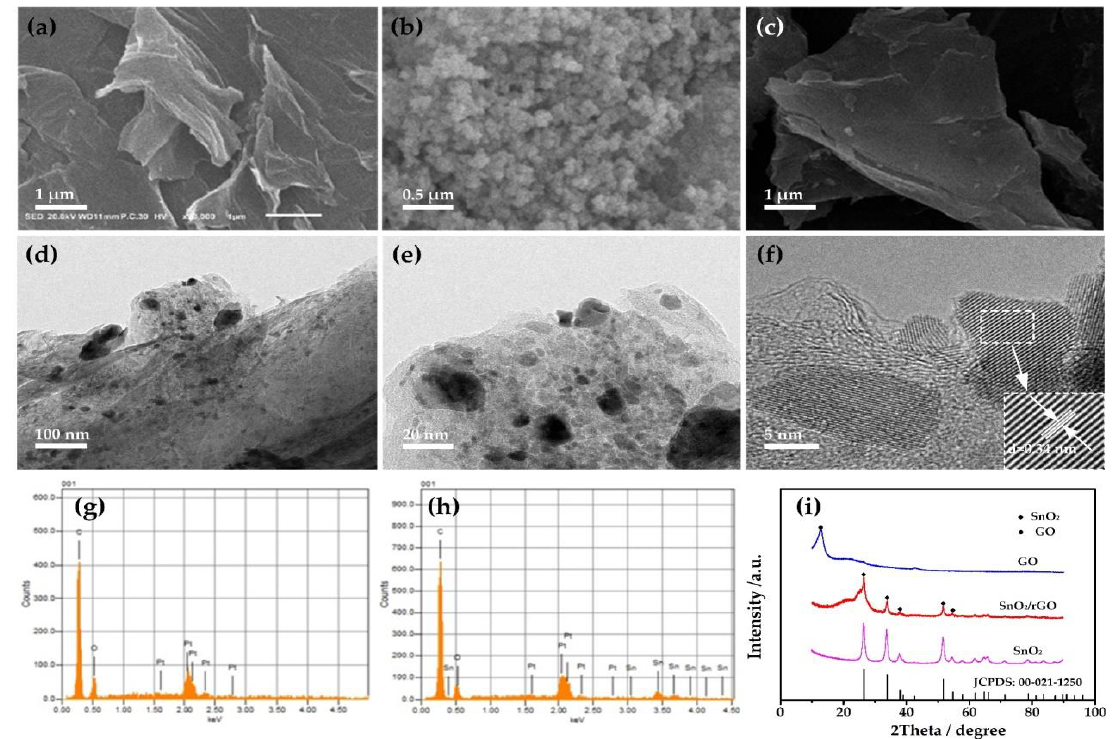
Molecules 2021 , 26 , x FOR PEER REVIEW Figure 2. ( a ) SEM image of GO; ( b ) SEM image of SnO 2 ; ( c ) SEM image of SnO 2 /rGO; ( d , e ) TEM images; ( f ) high-resolution TEM image of SnO 2 /rGO; ( g ) EDX spectra of GO; ( h ) EDX spectra of SnO 2 /rGO; ( i ) XRD patterns of all samples.